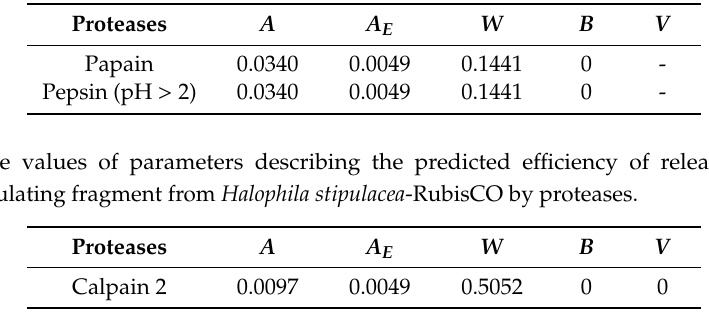
Table 8. The values of parameters describing the predicted e ffi ciency of release of bioactive stimulating fragment from Halophila stipulacea -RubisCO by proteases.